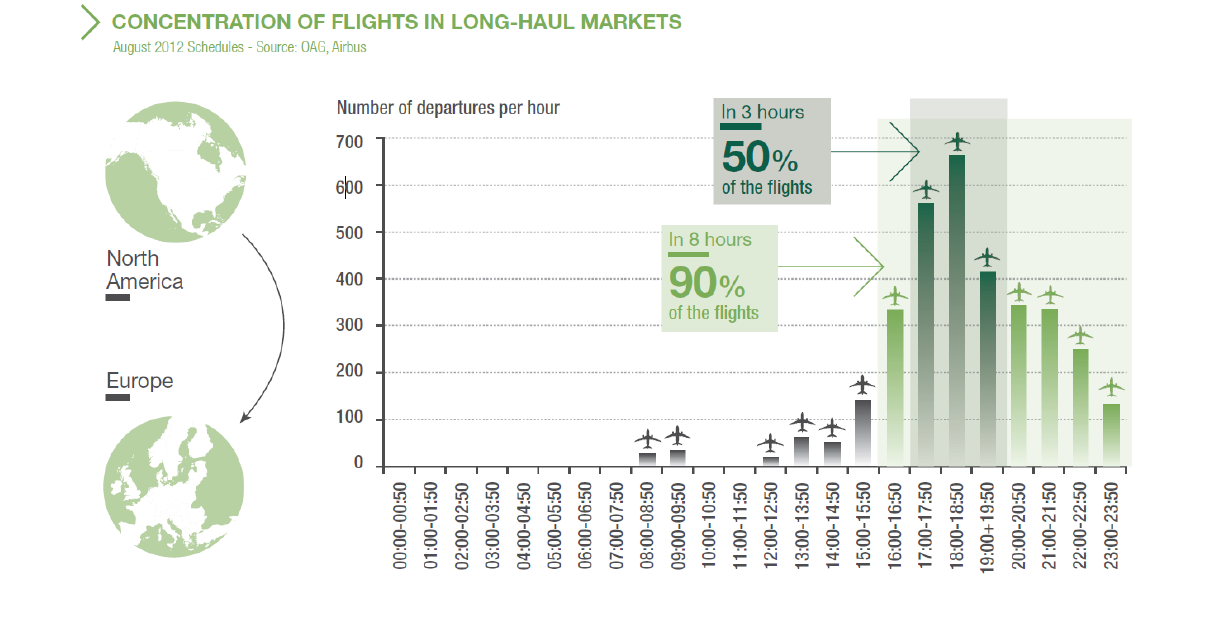
Figure 1. Concentration of Flights in Long-Haul Markets [source: OAG, Airbus].